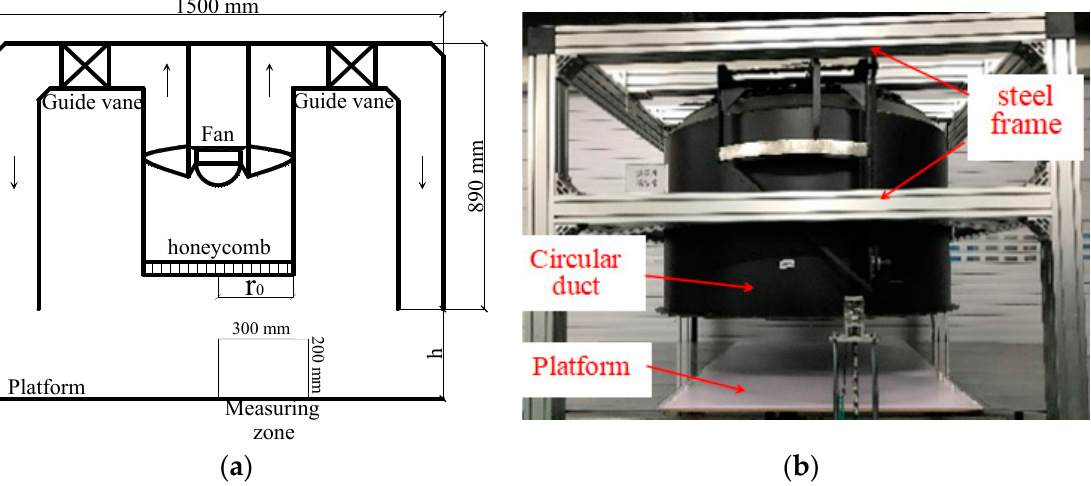
Figure 1. Schematic and picture of tornado ‐ vortex simulator at Beijing Jiaotong University. ( a ) The schematic of the TVS. ( b ) A picture of the TVS.